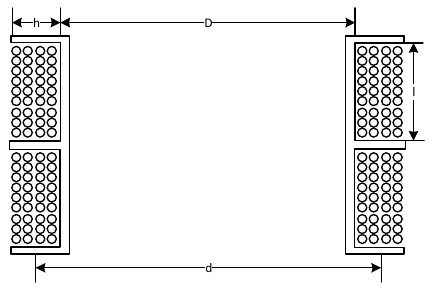
Figure 2. Air-core coil structure.